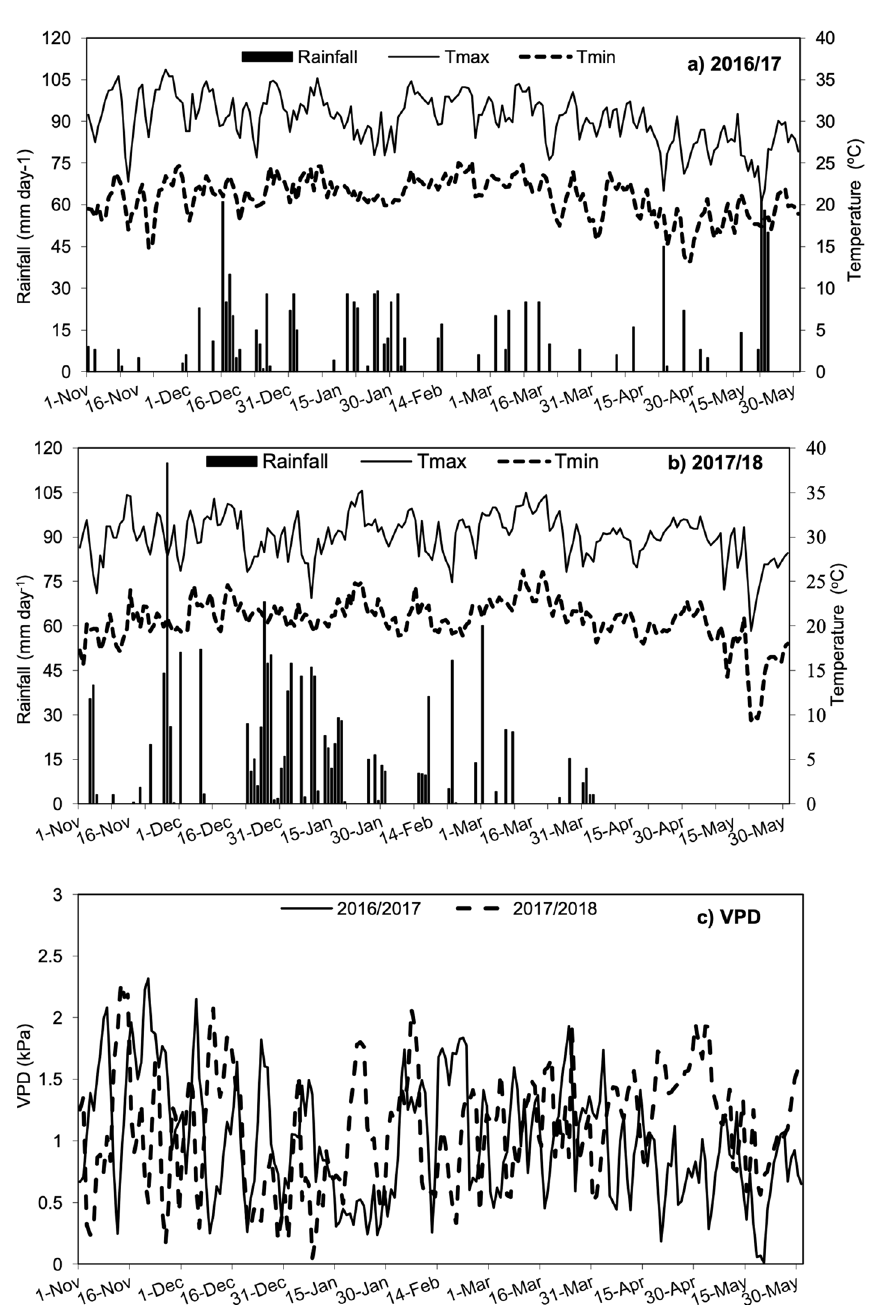
Figure 6. Rainfall, maximum and minimum temperatures, and vapor pressure deficit during the